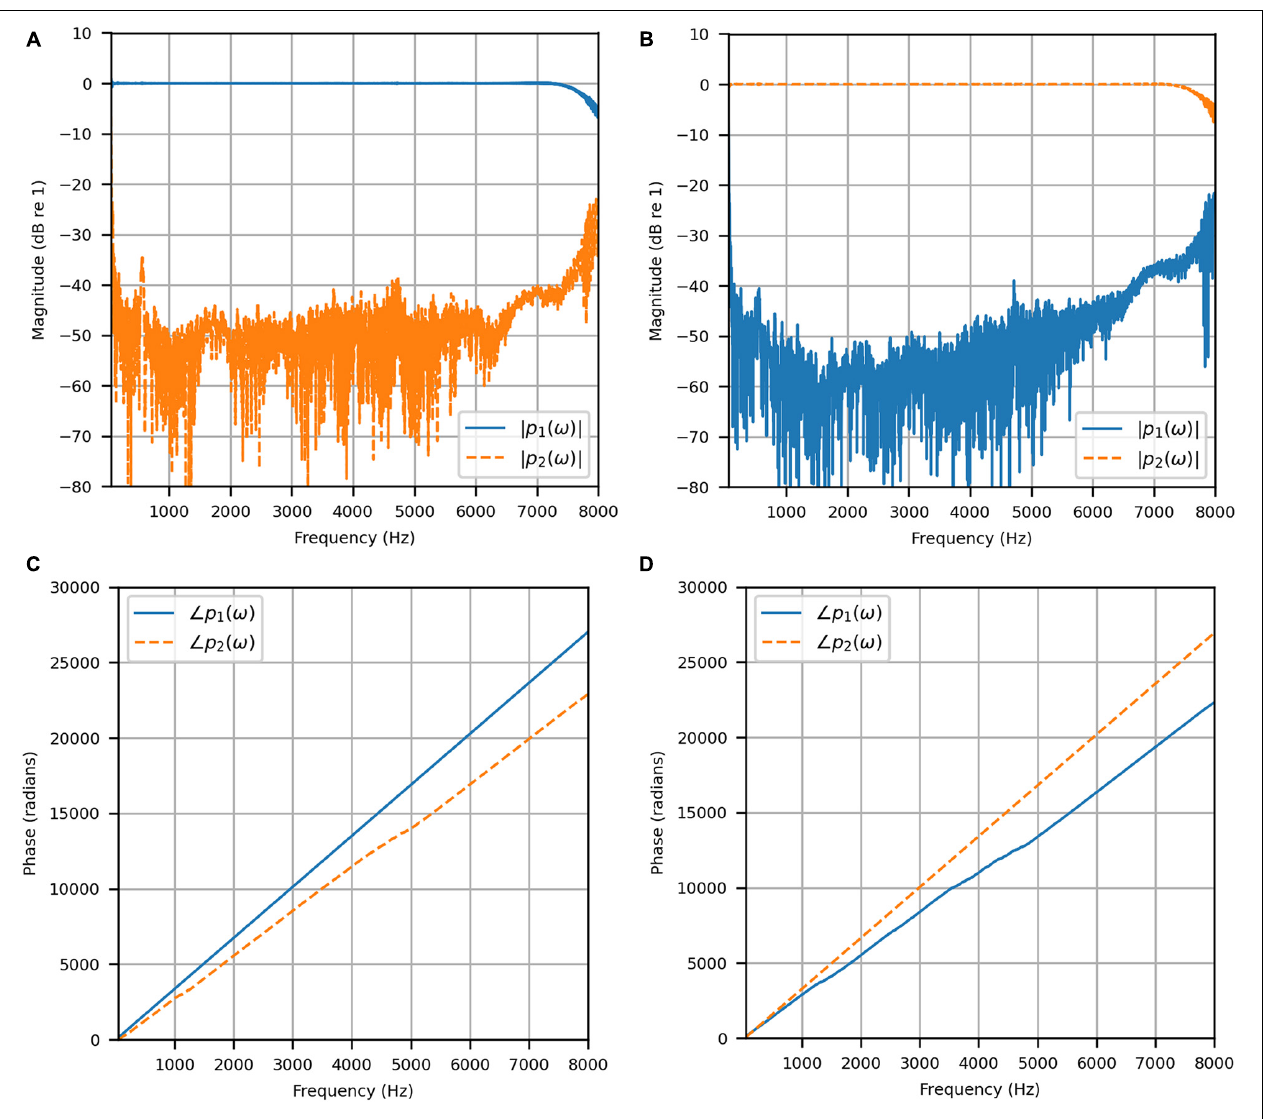
FIGURE 4 | Anechoic chamber: (A) Reproduced magnitude responses for a target impulse to the left microphone (blue solid); (B) Reproduced magnitude responses for a target impulse to the right microphone (red dashed); (C) Reproduced phase responses for a target impulse to the left microphone (blue solid); (D) Reproduced phase responses for a target impulse to the right microphone (red